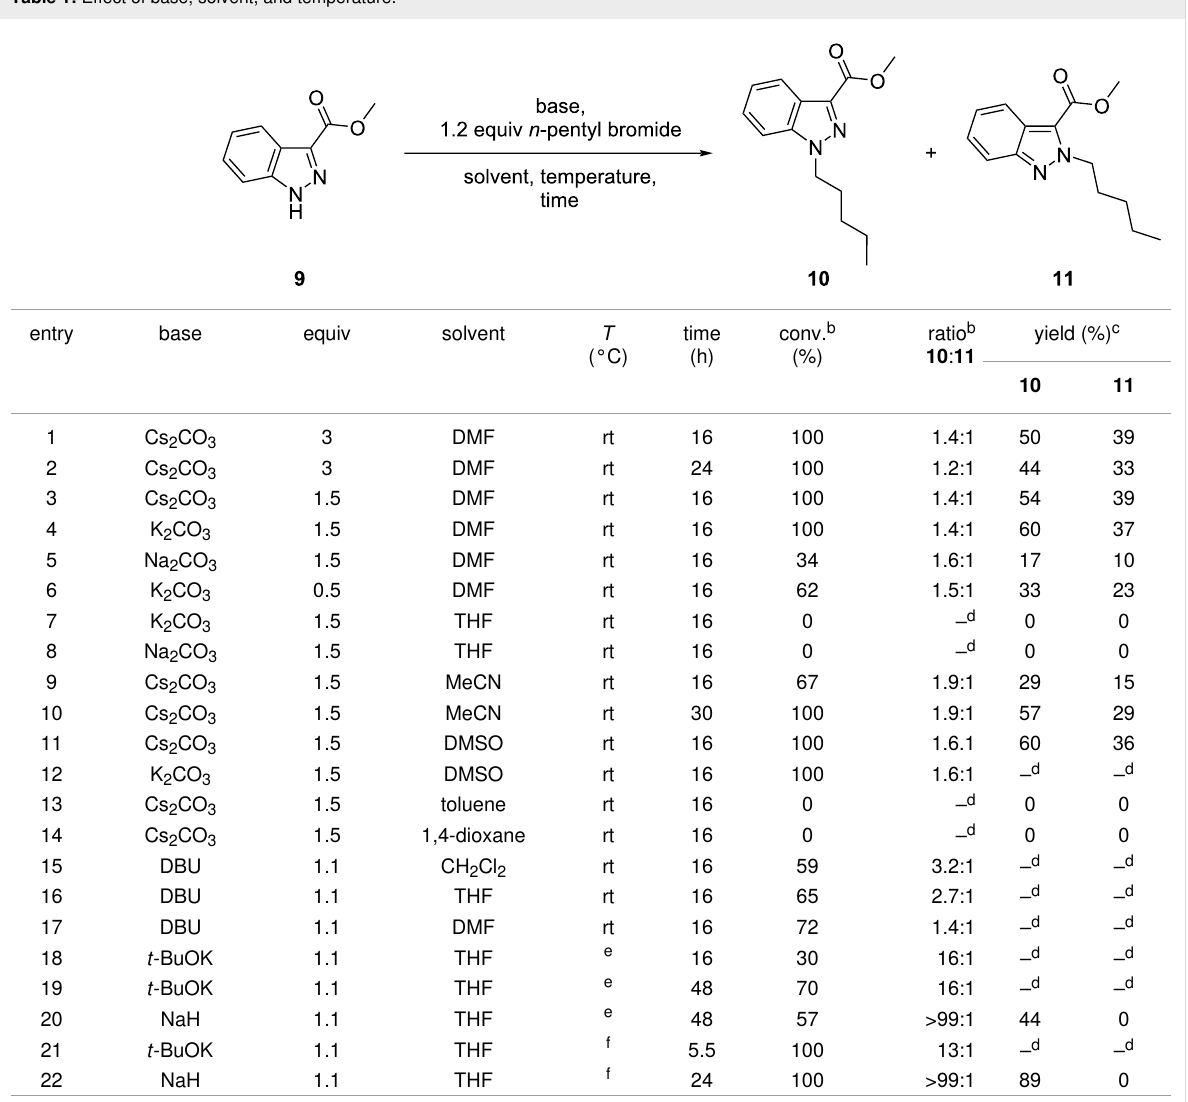
Table 1: Effect of base, solvent, and temperature.